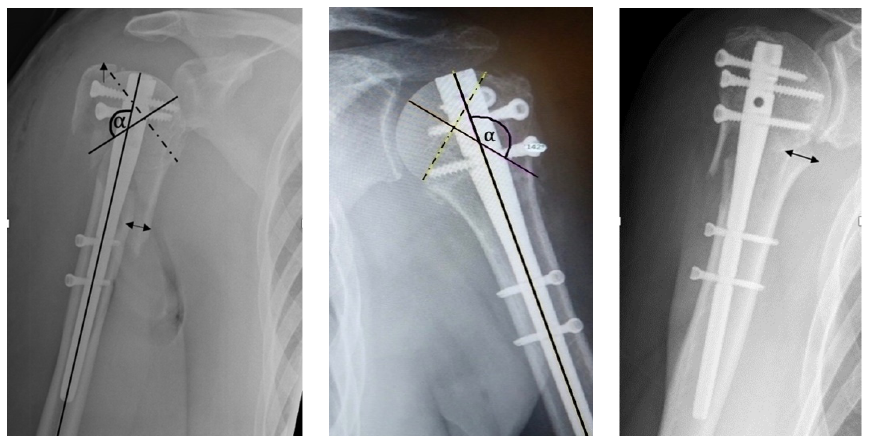
Figure 1. Left: Measurement: (1). Head-Shaft-Alignment (angle Alpha): We drew a first line (dashed) from the superior border to the inferior border of the articular surface. A second line was drawn perpendicular to the first line through the center of the humeral head. The third line shows the alignment of the humeral shaft. The angle alpha between the second and third line describes the head shaft alignment. (2). Head-Shaft-Displacement (two-way-arrow): Measurement between the medial shaft fracture line and the medial edge of the head (mm). (3). CTB (one-way-arrow): Measurement between the greater tuberosity and the cartilaginous fracture line (mm). [9]. Middle: Anatomical Reduction, using the described criteria Right: Head-Shaft-Displacement 15.4 mm. Table 1. Parameters of fracture